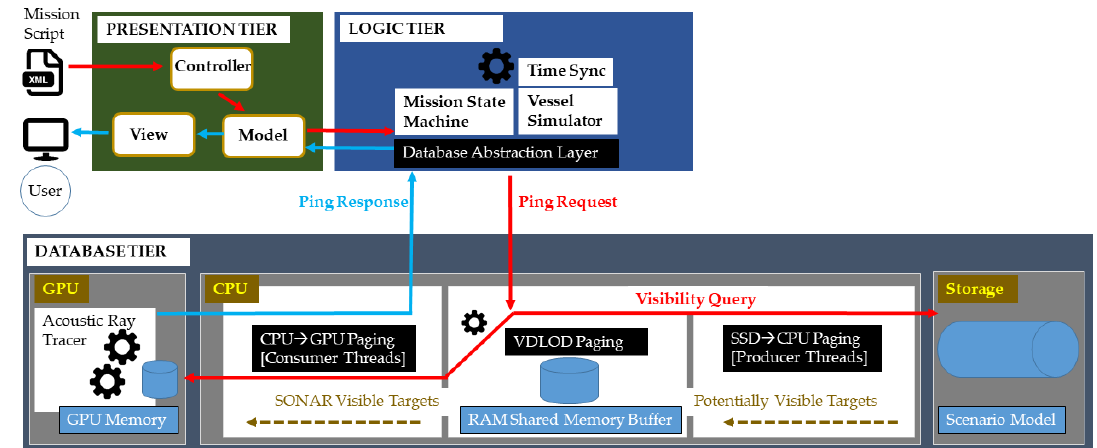
Figure 5. The simulator n-tier architecture.